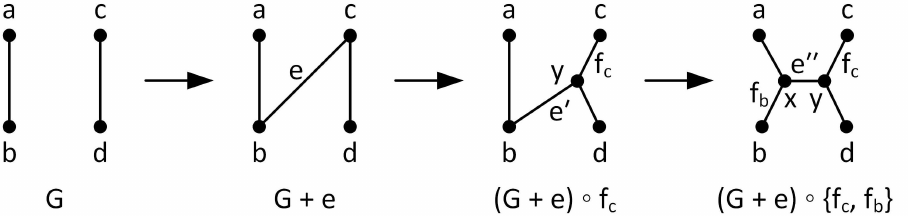
Figure 7. Operation D2 interpreted as an edge addition followed by two vertex